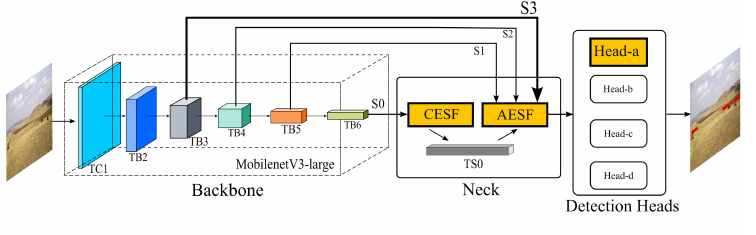
Figure 5. The archiecture of proposed Algorithm CNN (in Figure 4). The primary contribution in this paper is the section of the figure that is yellow and highlighted.